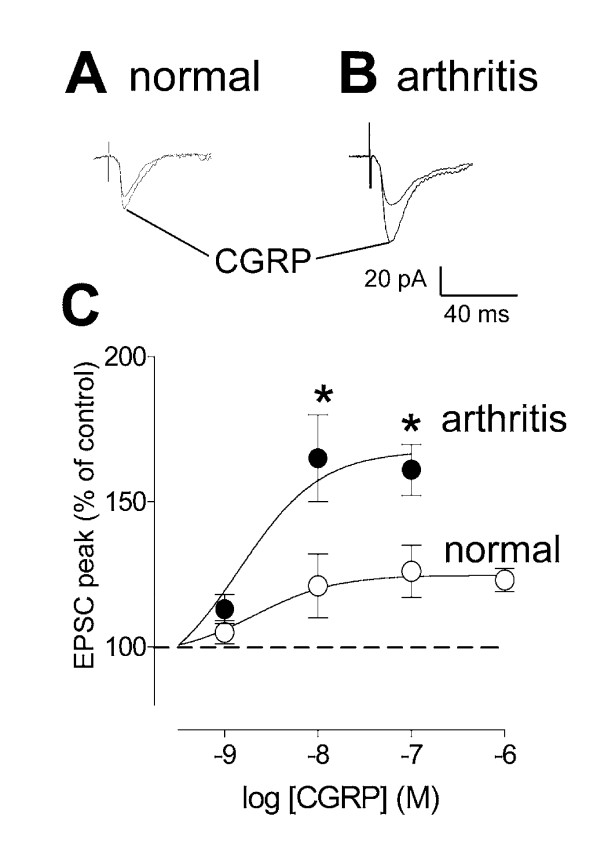
Enhanced synaptic facilitation by CGRP in the arthritis pain model. A, B, Whole-cell voltage-clamp recordings of monosynaptic EPSCs in an SG neuron in a slice from a normal animal (A) and in another SG neuron in a slice from an arthritic animal (B, 6 h postinduction of arthritis). CGRP (10 nM) potentiated synaptic transmission more strongly in arthritis than under normal conditions. Square wave electrical stimuli of 150 μs duration were delivered at a frequency < 0.25 Hz. Each trace is the average of 8–10 EPSCs. C, Concentration-response data show that the maximum effect (efficacy) of CGRP was significantly greater in SG neurons from arthritic rats (n = 16) compared to control neurons from normal animals (n = 10). Peak EPSC amplitudes during each concentration of CGRP were averaged and expressed as percent of predrug (baseline) control (100%). Sigmoid curves were fitted to the data using the following formula for nonlinear regression (GraphPad Prism 3.0; Y = A+(B-A)/[1+(10C/10X)D], where A = bottom plateau, B = top plateau, C = log(EC50), D = slope coefficient. Symbols show mean ± SEM. Neurons were held at -60 mV. CGRP was applied by superfusion of the slice in ACSF for 10 min. * P < 0.05 (two-way ANOVA followed by Bonferroni posttests).